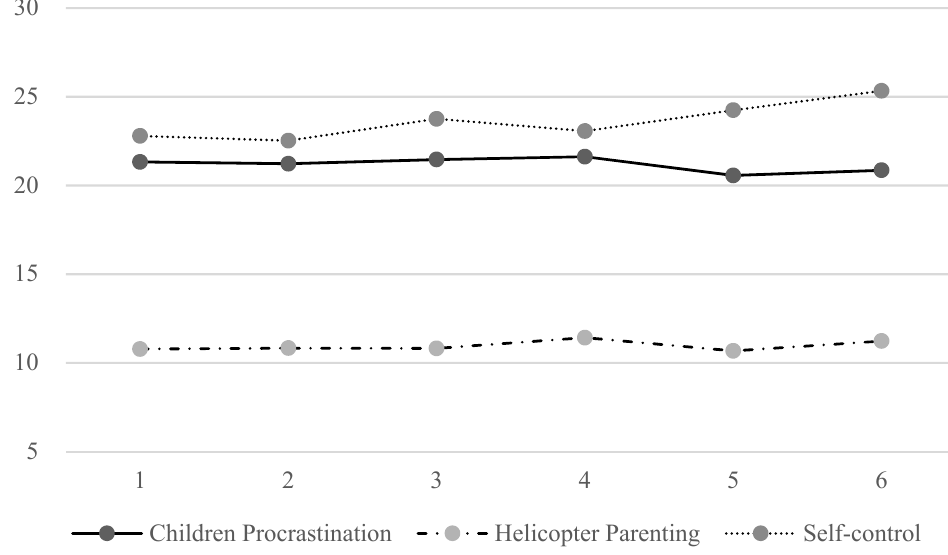
Figure 3. Grade development trend. Table 2. Independent t-test between boys and girls.